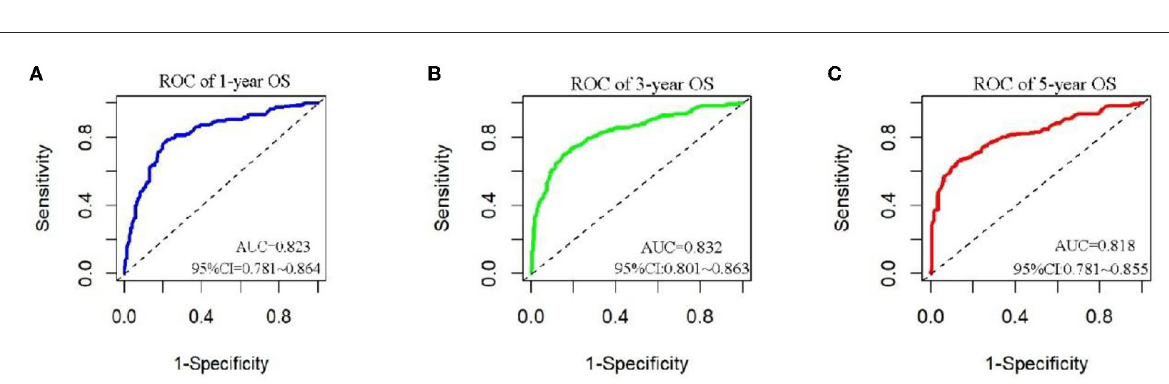
FIGURE6 ROC curves for 1, 3, and 5 years of appendix cancer prognosis in validation set patients. (A–C) Are ROC curves for validation sets 1, 3, and